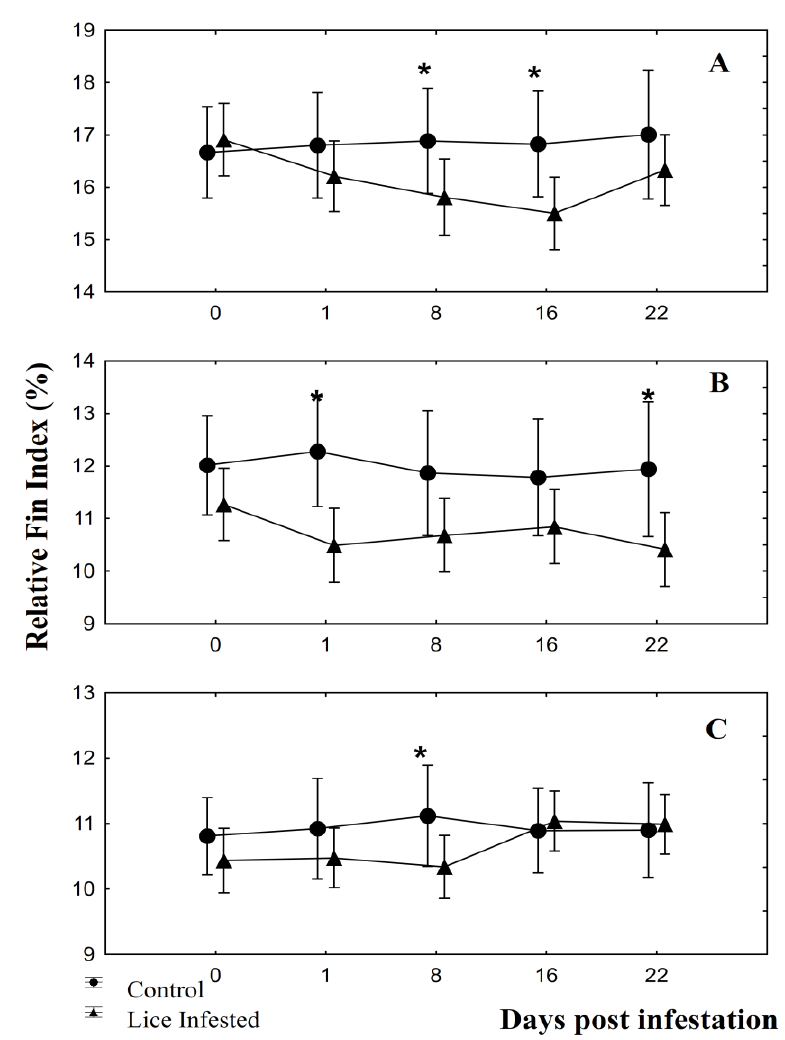
Figure 1. Relative fin index (%) of control and Caligus rogercresseyi infested groups of Atlantic salmon ( Salmo salar ), corresponding to ( A ) pectoral fins, ( B ) pelvic fins, and ( C ) anal fin during the time curse (days post infestation). Mean ± 0.95 Confidence Interval. Asterisks show significant differences ( p < 0.05) compared to the fish in the control group on that day.